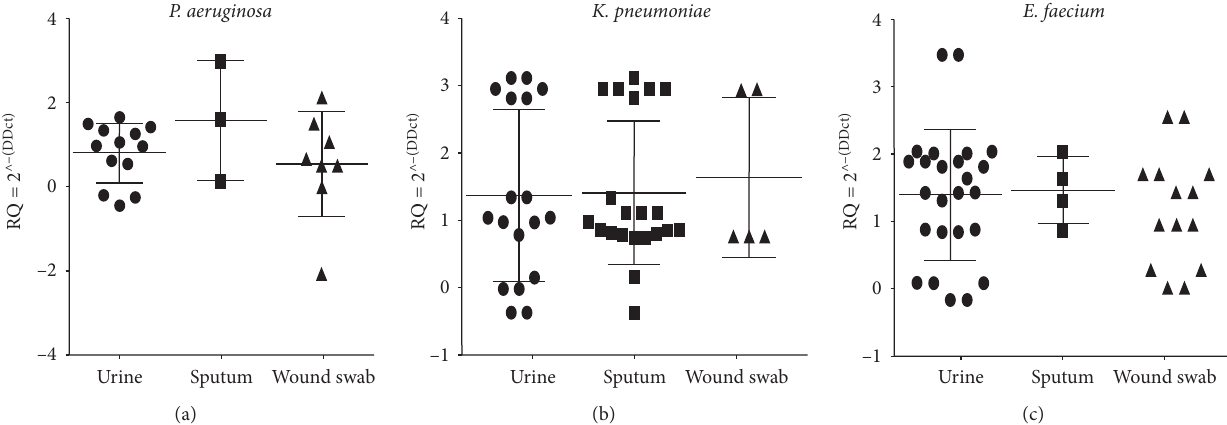
Figure 2: AmpC β -lactamase expression pattern, evaluated by RT-qPCR, among the isolates of bacterial species included in this study recovered from urine, sputum, and wound